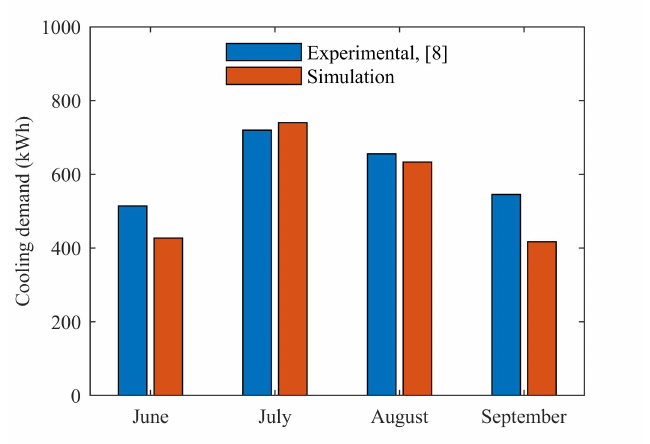
Figure 4. Comparison between experimental and predicted results. Building model.